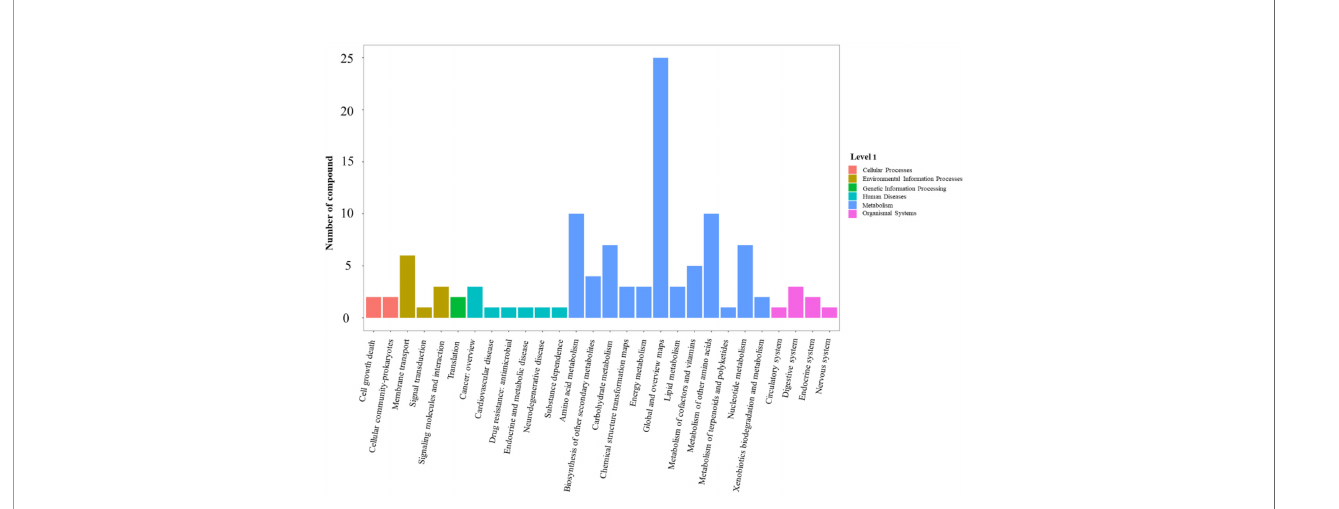
FIGURE 6 | Histogram of ions and metabolites annotated to KEGG pathways. The fold changes were used to identify differential metabolites based on partial least squares method-discriminant analysis (PLS-DA) and variable importance in projection (VIP) value. Pathways with differential metabolite were enriched using KEGG pathway database. X-axis shows the pathways of level 2 derived from pathways of level 1 (cellular processes, environmental information processing, genetic information processing, human diseases, metabolism and organismal system) in KEGG database. Y-axis shows the number of compounds enriched in the pathway. The signi fi cantly enriched pathways (such as global and overview maps, amino acid metabolism and metabolism of other amino acid) are pathways from metabolism (blue bar). KEGG, Kyoto Encyclopedia of Genes and